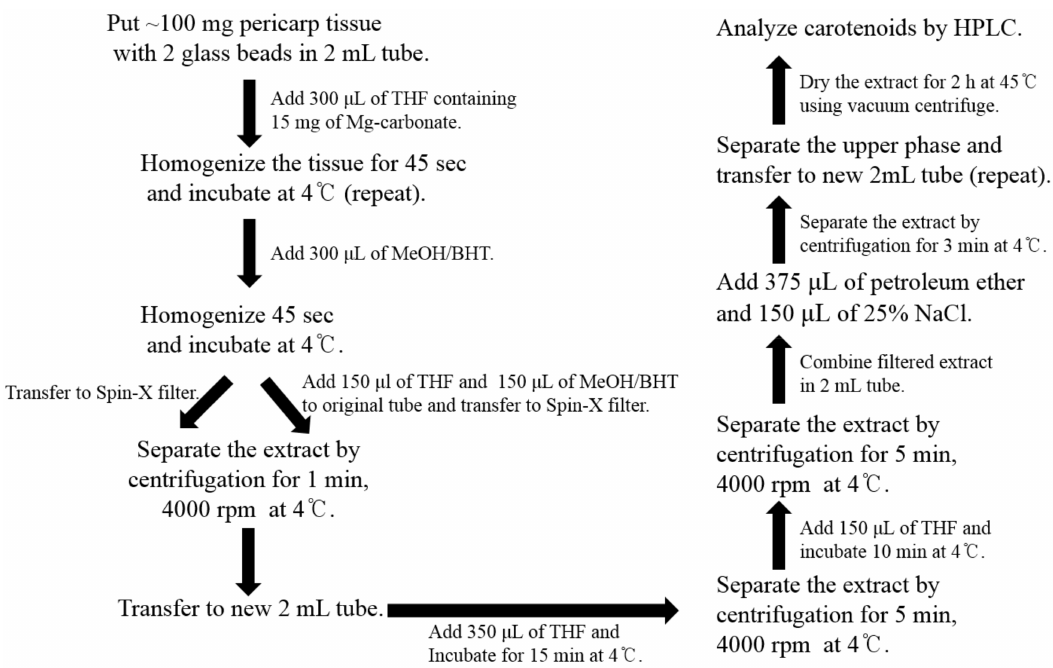
Scheme 2. Procedure for carotenoid extraction from the tomato pericarp. THF, tetrahydrofuran;